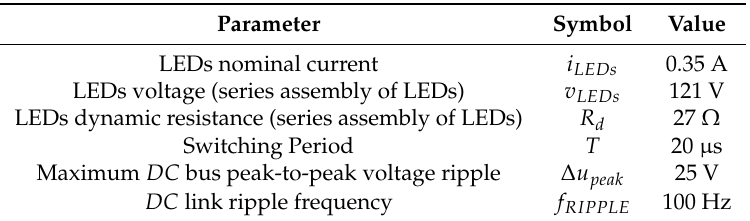
Table 2. Initial Design